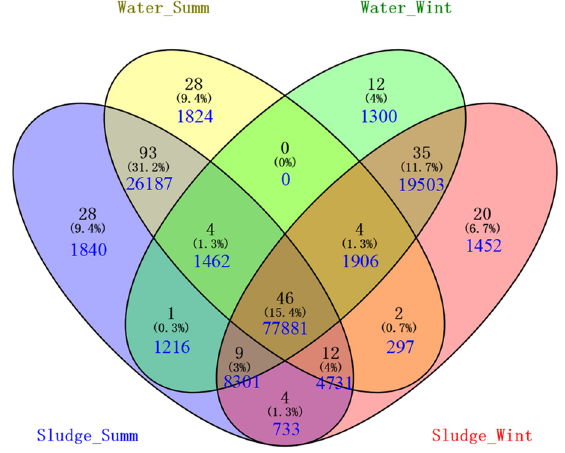
Figure 3. Conserved and unique OTUs in four groups (yellow, raw water in summer; green, raw water in winter; blue, sludge in summer; and red, sludge in winter).